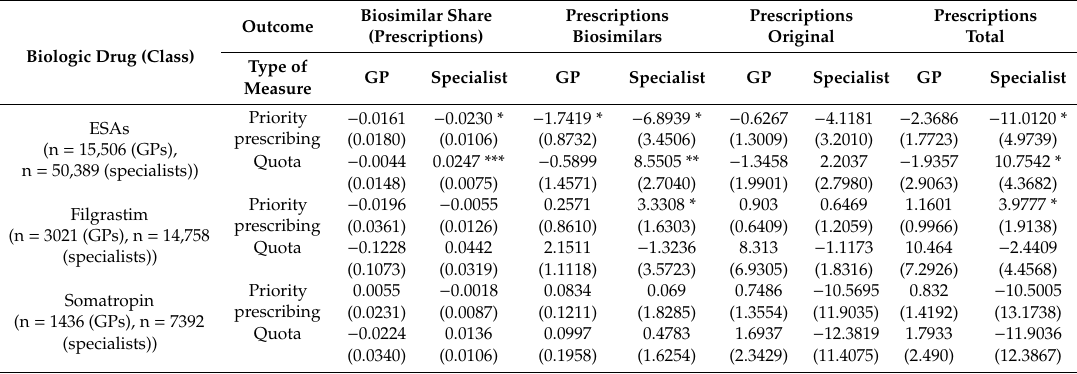
Table 5. Two-way fixed e ff ects regression by drug (class), specialization, and outcome; associations with PA measures for biosimilar prescribing, controlling for physician and time fixed e ff ects, all physicians, and balanced panel,